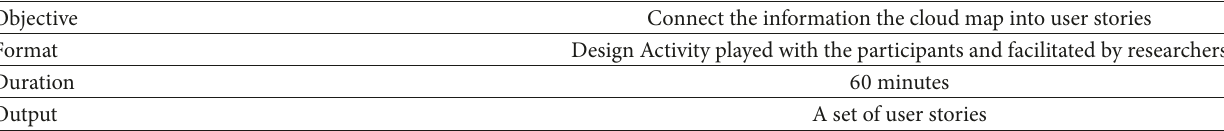
Table 4: Summary of the characteristics of Session 3.